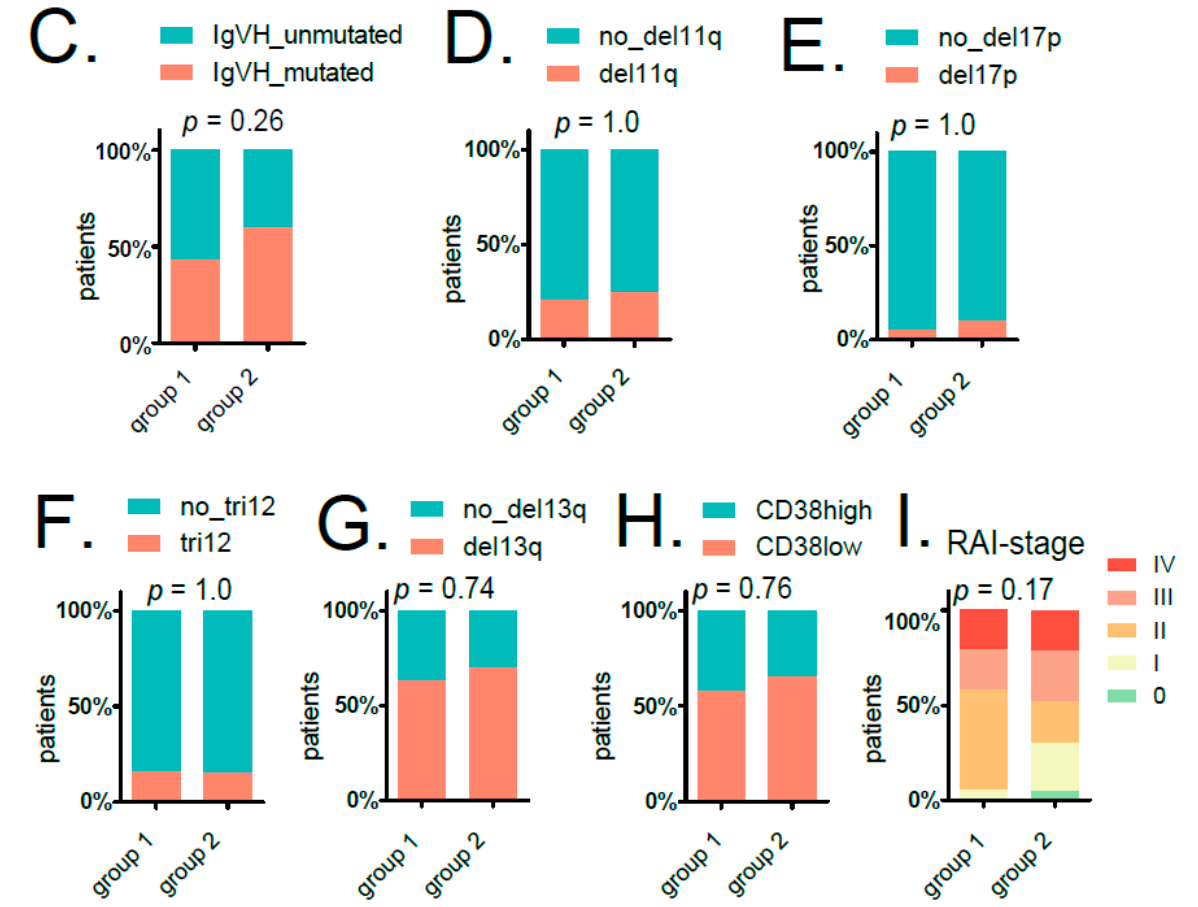
Figure 5. Correlation of LGT events with clinically relevant parameters. ( A ) Kaplan–Meier overall survival (OS, left) and progression-free survival (PFS, right) curves comparing patients grouped according to MDS analysis of LGT events (groups 1 and 2). ( B ) Kaplan–Meier overall survival (OS, left) and progression-free survival (PFS, right) curves comparing patients with higher (LGThigh, in yellow) and lower (LGTlow, in blue) amounts of bacterial integrations (cutoffs calculated by Cox regression analysis). For all survival plots’ p -values, confidence intervals as well as horizontal and vertical median survival lines are indicated. The stacked bar plots show the percentage of patients in group 1 and group 2 either featuring IGVH mutation ( C ), del11q ( D ), del17q ( E ), tri12 ( F ), del13q ( G ) or not. ( H ) The stacked bar plot indicates the percentage of patients in group 1 and group 2 with either high or low CD38. For ( C – H ), significances were calculated with a two-sided Fisher’s exact test. ( I ) The stacked bar plot displays the percentage of patients in group 1 and group 2 in different stages according to the assigned RAI index. Significance was calculated with Pearson’s chi-squared test.